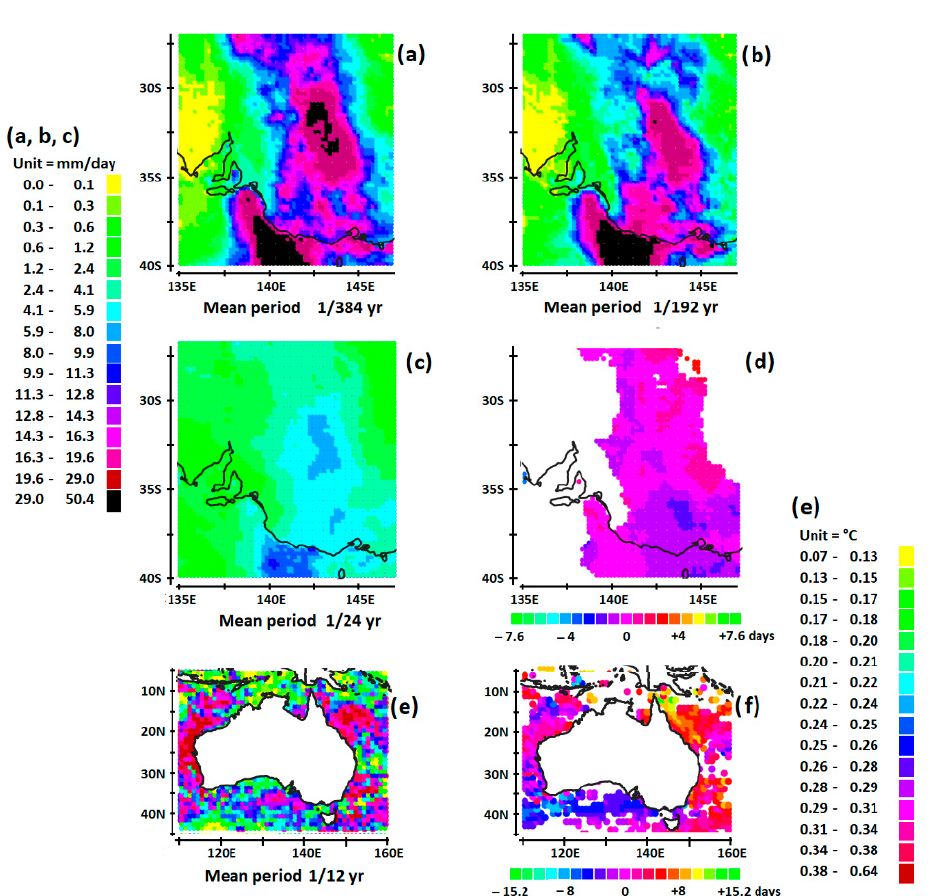
Figure 12. Extreme rainfall in Victoria, Australia. Same conventions as in Figure 7. Time lags in ( d , f ) are expressed in relation to 13 January 2011. The time reference is the rainfall depth at 32° S, 143° E. Co-Evolution of SST and Rainfall Anomalies in Characteristic Period Ranges Clustering of mesoscale lows occurs in tune with the 1/24 harmonic (Figure 12c,d), while the extratropical cyclone is moving slowly south–north. Two SST anomalies between 0.38 and 0.64 ◦ C are located in the Pacific Ocean off the coasts of southeastern and north- eastern Australia (Figure 12e,f). The SST anomaly off the coast of southeast Australia occurs along the western boundary current, i.e., the Eastern Australian Current Extension, and the SST anomaly off the coast of northeast Australia occurs along the South Equatorial Current. Both SST anomalies are a few days behind the